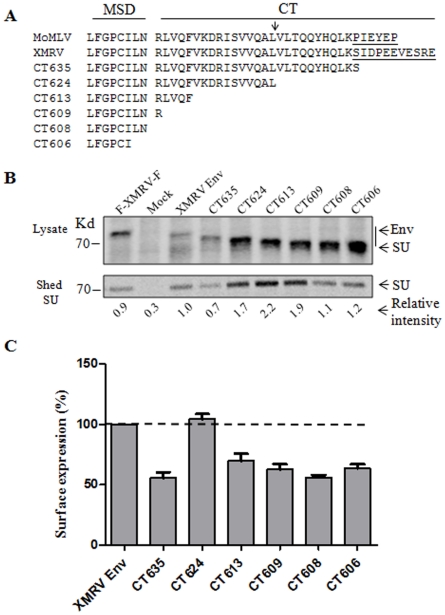
C-terminal truncation of XMRV Env induces SU shedding.(A) Sequence alignment of MoMLV and XMRV Env constructs. MSD: membrane spanning domain. CT: cytoplasmic tail. Arrow: indicates the MoMLV Env R-peptide cleavage site. Underlined: The CT region that differs between XMRV and MoMLV. (B) 293T cells expressing XMRV Env were metabolically labeled for 1 h and chased for 4 h. Env proteins in cells lysates and shed in the culture media were immunoprecipated, resolved by SDS-PAGE and subjected to autoradiography. Band density was measured using the Quantity One software and values were normalized to the intensity of the XMRV Env SU set to 1.0. Representative experiment is shown (n = 2). (C) The expression of XMRV Env on the 293T cell surface was measured using anti-FLAG and flow cytometry. Fluorescence geometric means were normalized to XMRV Env (100%). Shown are the averages of 3 independent experiments ± S.D. XMRV Env: XMRV Env tagged with a FLAG sequence only at the N-terminus. All truncations were also tagged similarly with an N-terminal FLAG. F-XMRV-F: an XMRV Env construct that is tagged by FLAG sequences on both N- and C-termini. Mock: untransfected 293T cells.